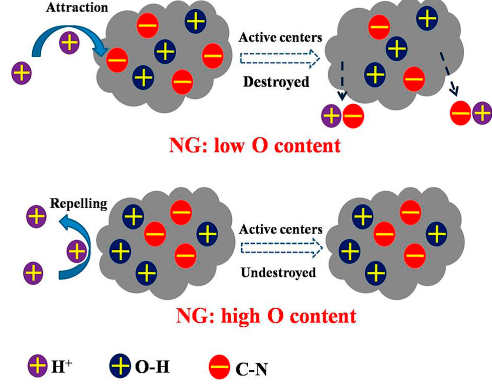
Figure 11. C-N groups on the surface of nitrogen-doped graphene (NG) were protected from the assault of protons by O-H groups. Adapted from [50], with permission from © 2013 American Chemical